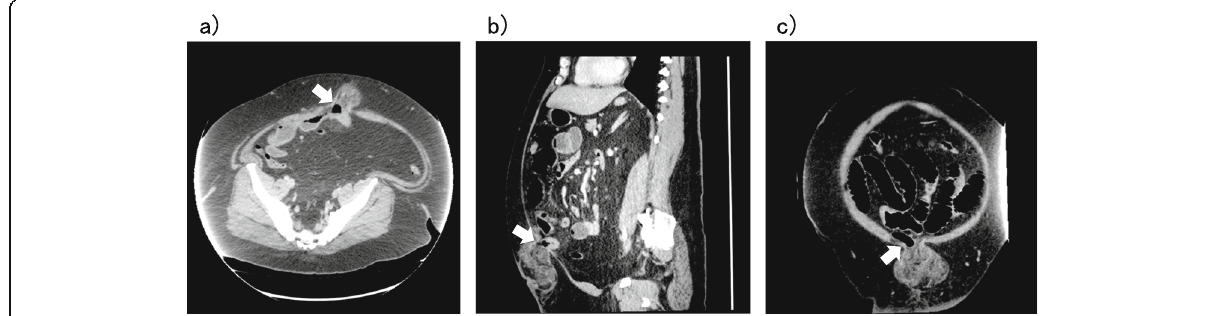
Fig. 2 Abdominal contrast-enhanced CT. The greater omentum and small intestine appear incarcerated (arrow). a Horizontal section. b Coronal section. c Sagittal section